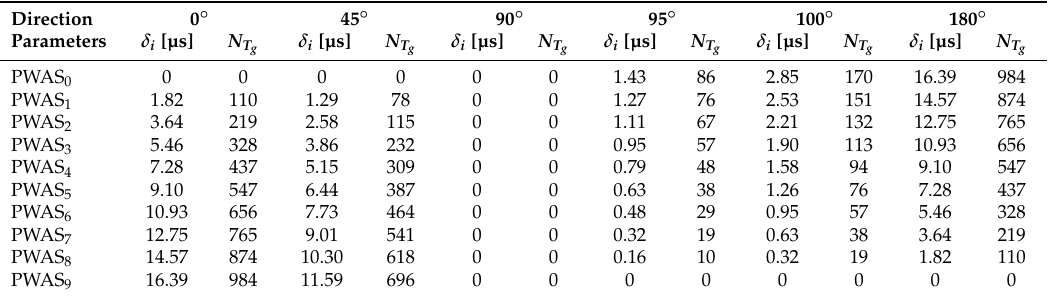
Table 1. Time delays and corresponding number of periods of the generator clock for different angles used for the transmission